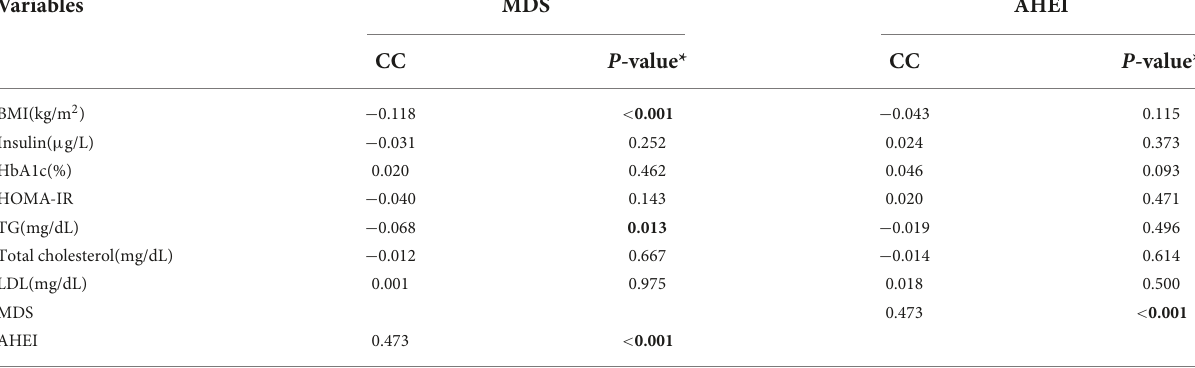
TABLE 4 Correlation of dietary indices MDS and AHEI with cardiometabolic biomarkers.